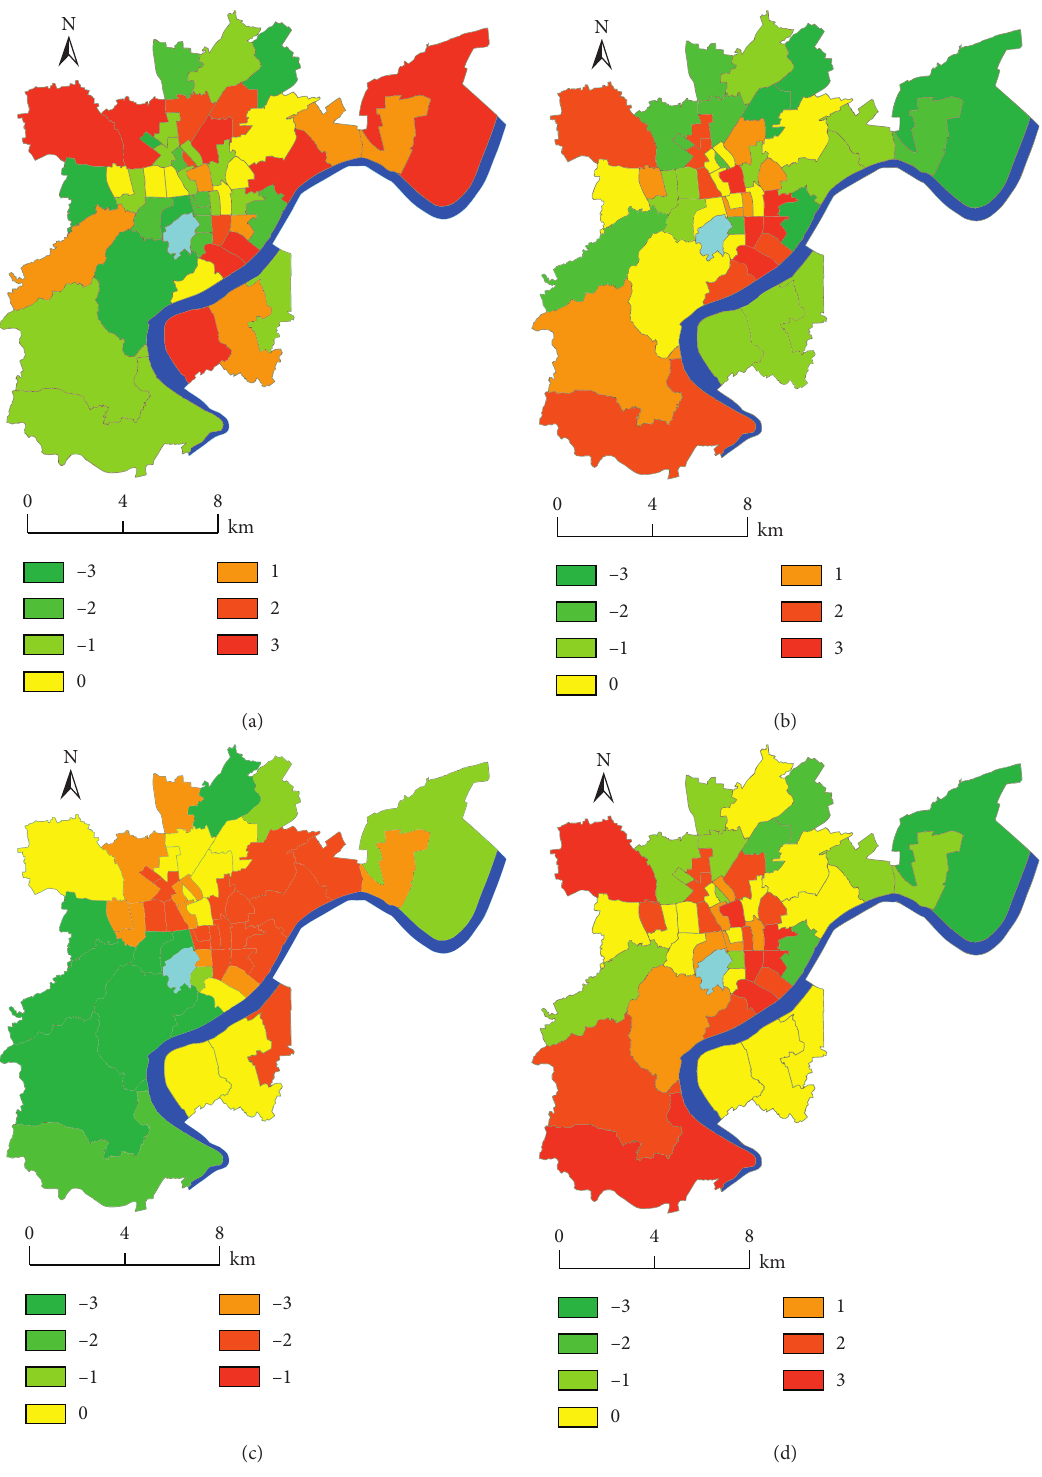
Figure 5: Spatial distributions of heat vulnerability using the PCA method: (a) Component 1: education/income/unhealthy seniors/elderly living along/illiteracy; (b) Component 2: elderly/cooling facilities; (c) Component 3: lack of green space/LST; (d) the final vulnerability through aggregating three